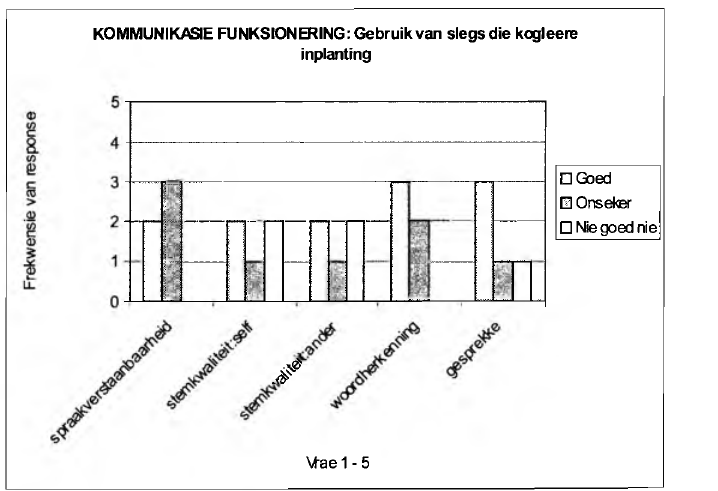
Figuur 2a: Response van deelnemers aangaande die gebruik van slegs die kogleere inplanting in terme van kommunikasie